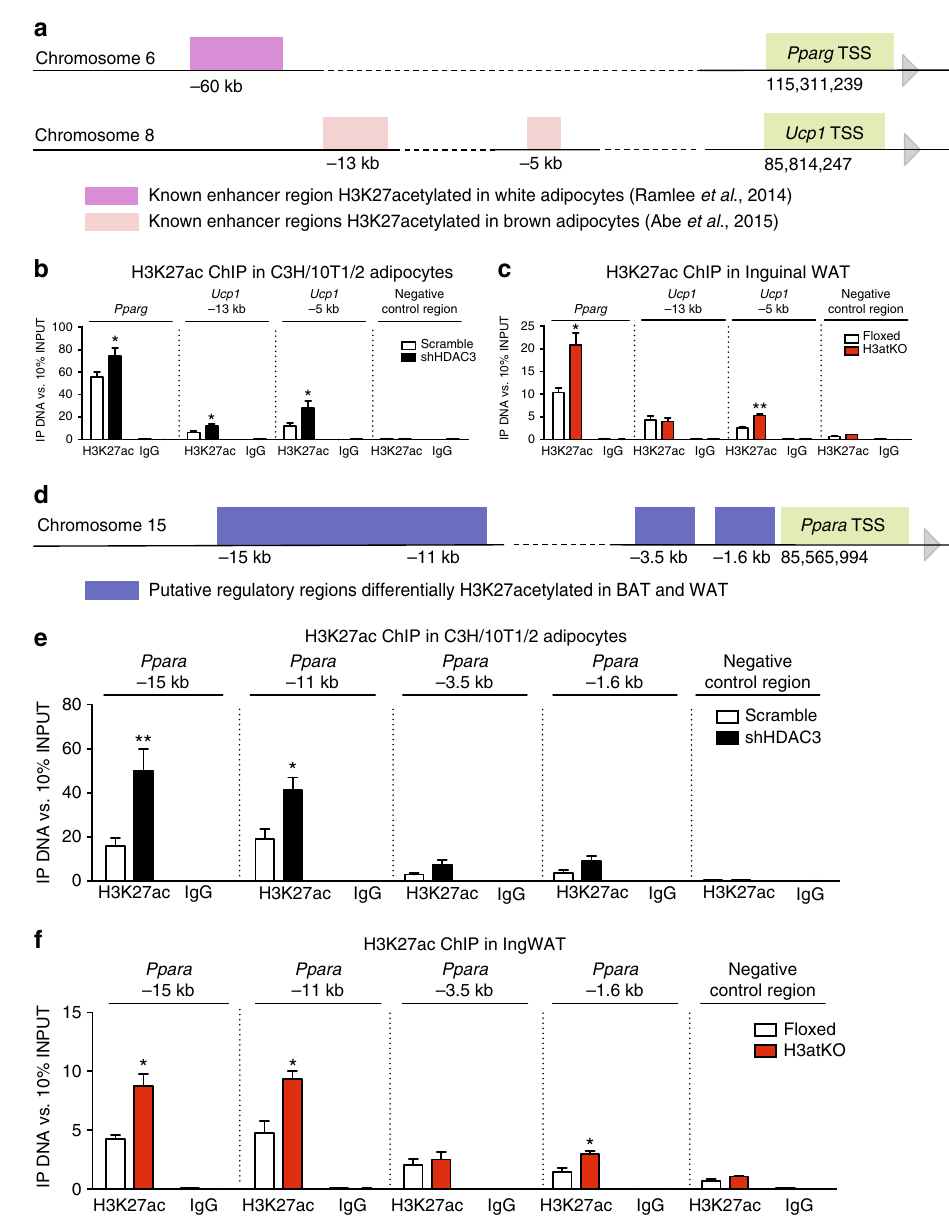
Fig. 5 Adipose ablation of HDAC3 remodels chromatin acetylation in “ hot regions ” . a Schematic representation of known Pparg and Ucp1 enhancers; b ChIP analysis showing H3K27ac enrichment on Pparg and Ucp1 enhancers in C3H/10T1/2 cells with Hdac3 knock down ( n = 6 per group); c ChIP analysis showing H3K27ac enrichment on Pparg and Ucp1 enhancers in IngWAT of H3atKO mice ( n = 3 per group, where each sample represent a pool from two individual mice); d Schematic representation of putative regulatory regions of Ppara gene; e ChIP analysis showing H3K27ac enrichment on putative regulatory regions of Ppara gene in C3H/10T1/2 cells with Hdac3 knock down ( n = 6 per group) f ChIP analysis showing H3K27ac enrichment on putative regulatory regions of Ppara gene in IngWAT of H3atKO mice ( n = 3 per group where each sample represent a pool from 2 individual mice). Data are presented as mean ± s.e.m. Statistical analysis: Student ’ s t -test, * p < 0.05 and ** p <